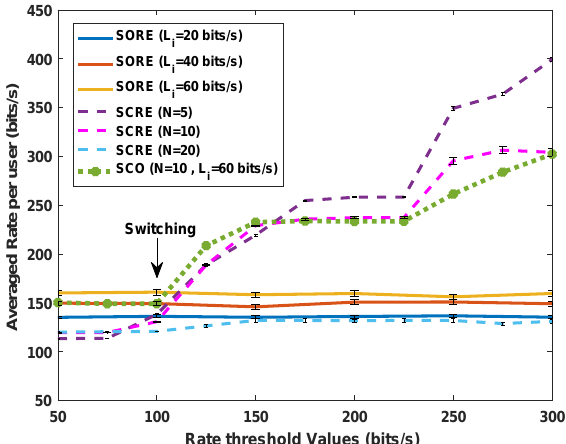
Figure 6. Averaged Achievable data rates per user by changing Rate threshold values in Cooperative Communication and by taking 20, 40, 60 leftover capacity in Wi-Fi offloading and overall 3 SBSs, 10 UEs and 10